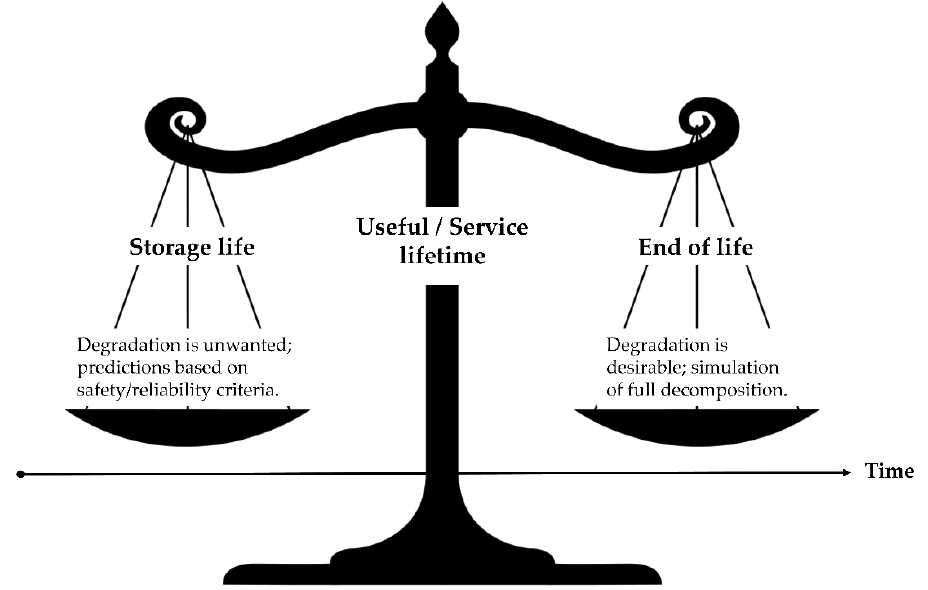
Figure 1. Time scale and critical points for materials’ life show the “two-edged sword” nature of the degradation processes ( clipart is attributed to “Scale Clipart Transparent—Creative Commons Clipart” ).